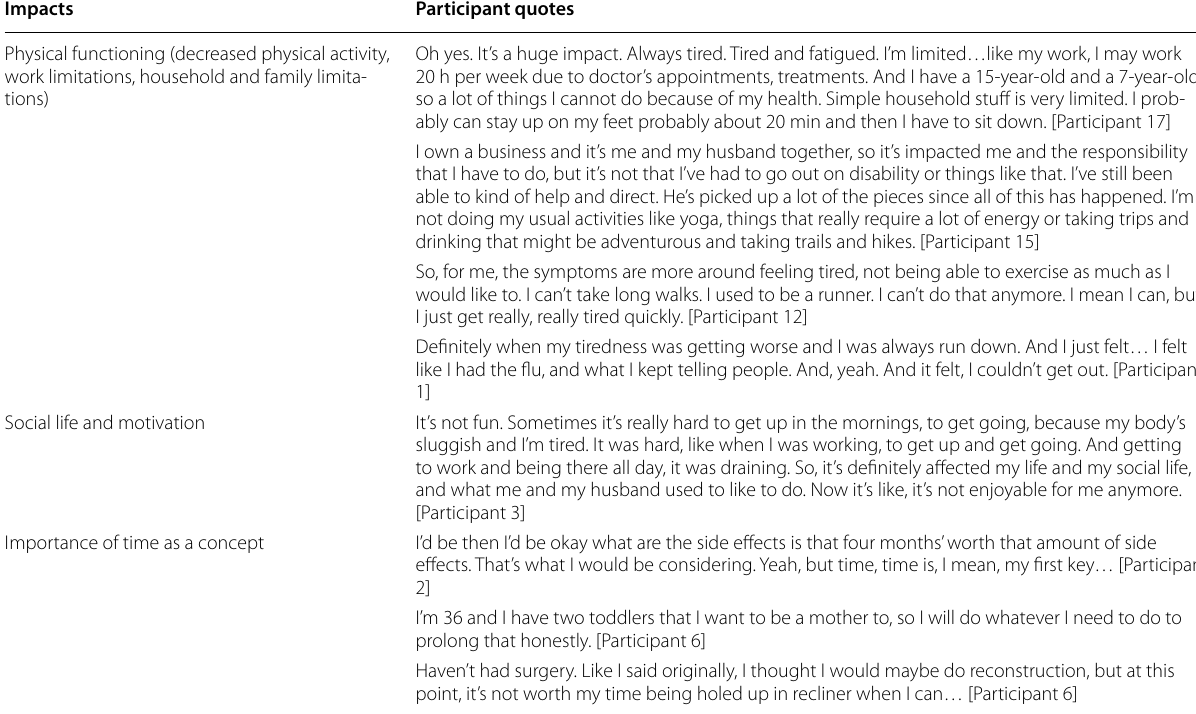
Table 3 Participant quotes describing impacts on patients’ lives Impacts Participant quotes Physical functioning (decreased physical activity, work limitations, household and family limita-